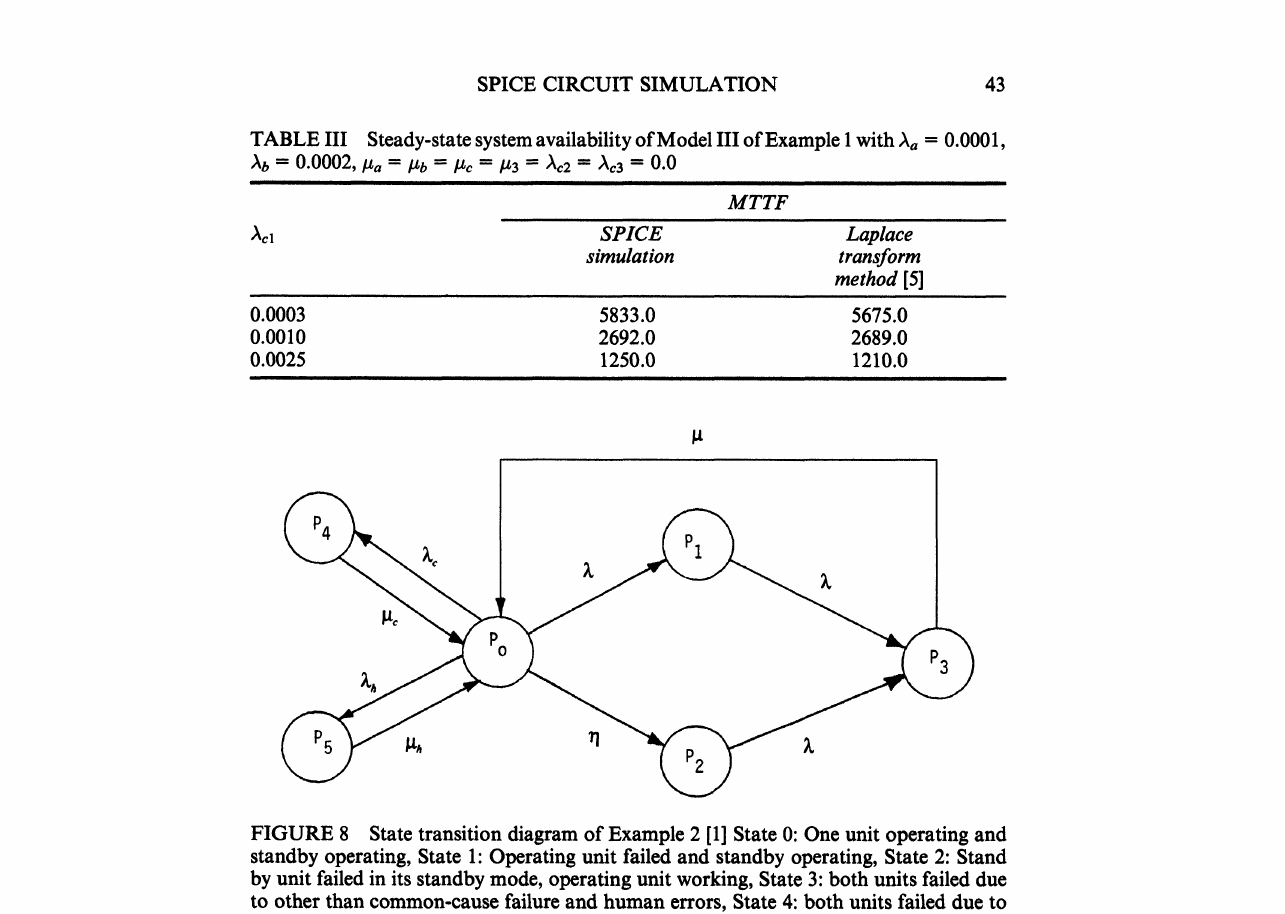
FIGURE 8 State transition diagram of Example 2 [1] State 0: One unit operating and standby operating, State 1: Operating unit failed and standby operating, State 2: Stand by unit failed in its standby mode, operating unit working, State 3: both units failed due to other than common-cause failure and human errors, State 4: both units failed due to common-cause failure, State 5: both units failed due to a human